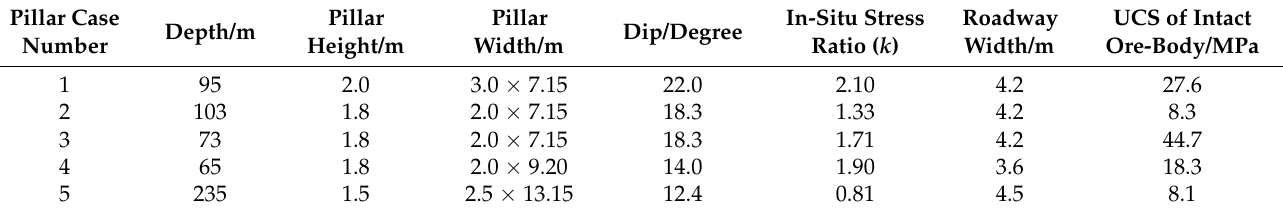
Table 1. Failed inclined pillar cases [32,33].